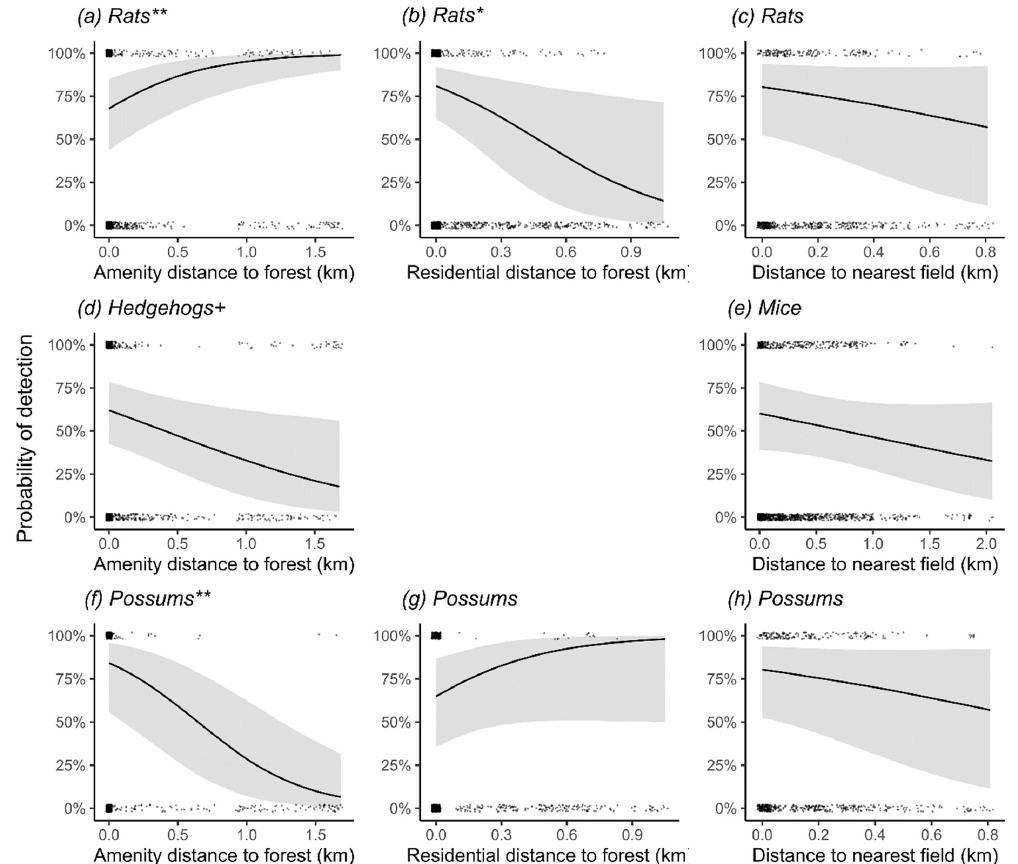
Figure 3. Model covariate effect plots showing change in predicted detection probability (90% CI shaded) of rats, hedgehogs, mice and possums in relation to distance covariates (km). Black dots are the raw data values of the response variable, indicating detection (top of each graph, representing 1), and non-detection (bottom, representing 0). Data for rodents are conditioned on Season = Autumn, City = Wellington, Habitat type = Forest, and Method = Camera. For hedgehogs and possums, City = Dunedin. All other continuous covariates are set to mean values. As there were no interaction terms between covariates in these models, the plotted relationships are constant across all factor combinations, with only the intercept position changing. +, * and ** indicate statistical significance as defined in Table 2.